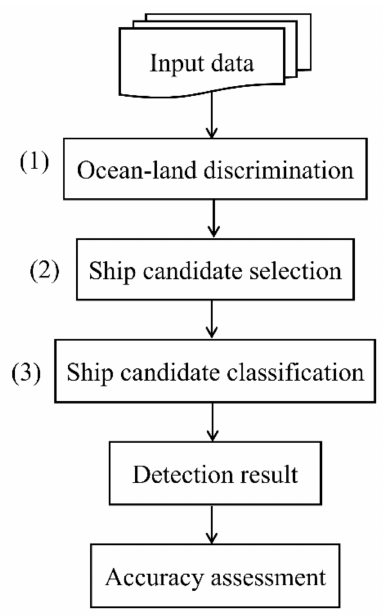
Figure 9. A general ship detection method using spaceborne RS